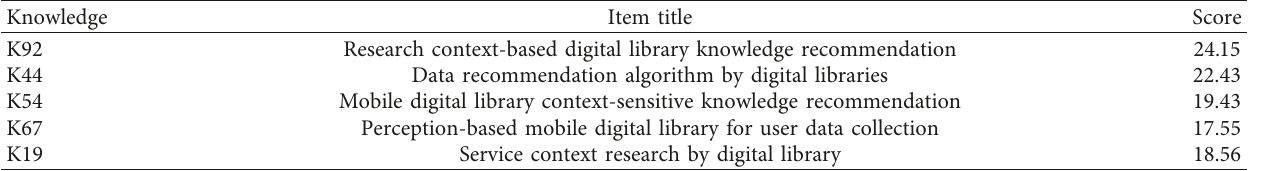
Table 4: The list of knowledge